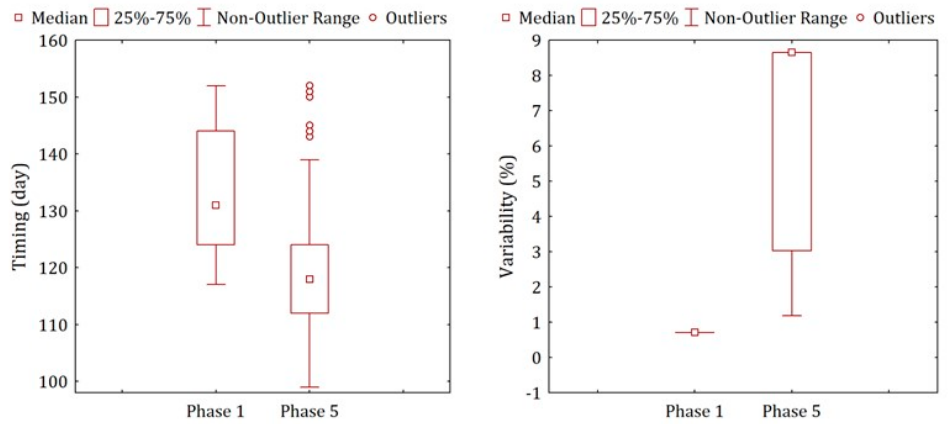
Figure 15. Comparison of timing and variability of low flows in the hydropower dam disturbance period.